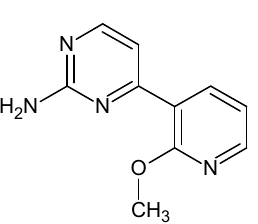
Figure 6. The structure of 4-(2-methoxypyridin-3-yl)pyrimidin-2-amine. 4-(2-Methoxypyridin-3-yl)pyrimidin-2-amine (Figure 6). A 100 mL round bottom flask was sequentially